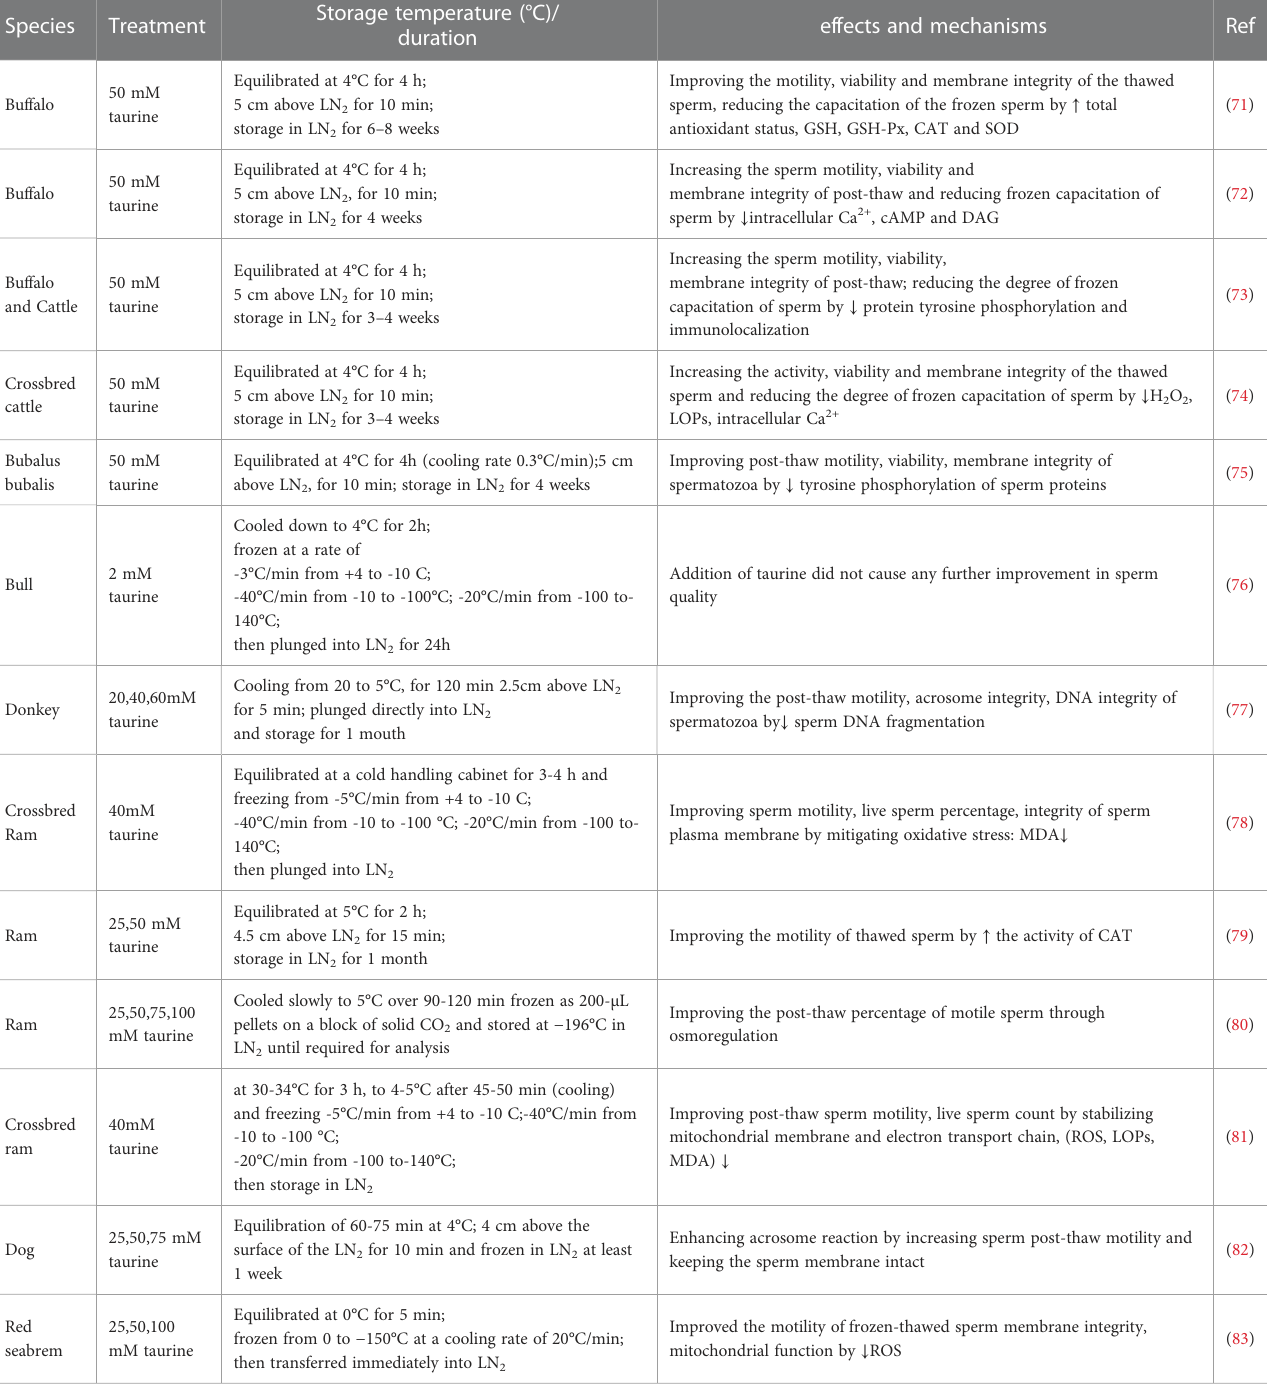
effects and mechanisms